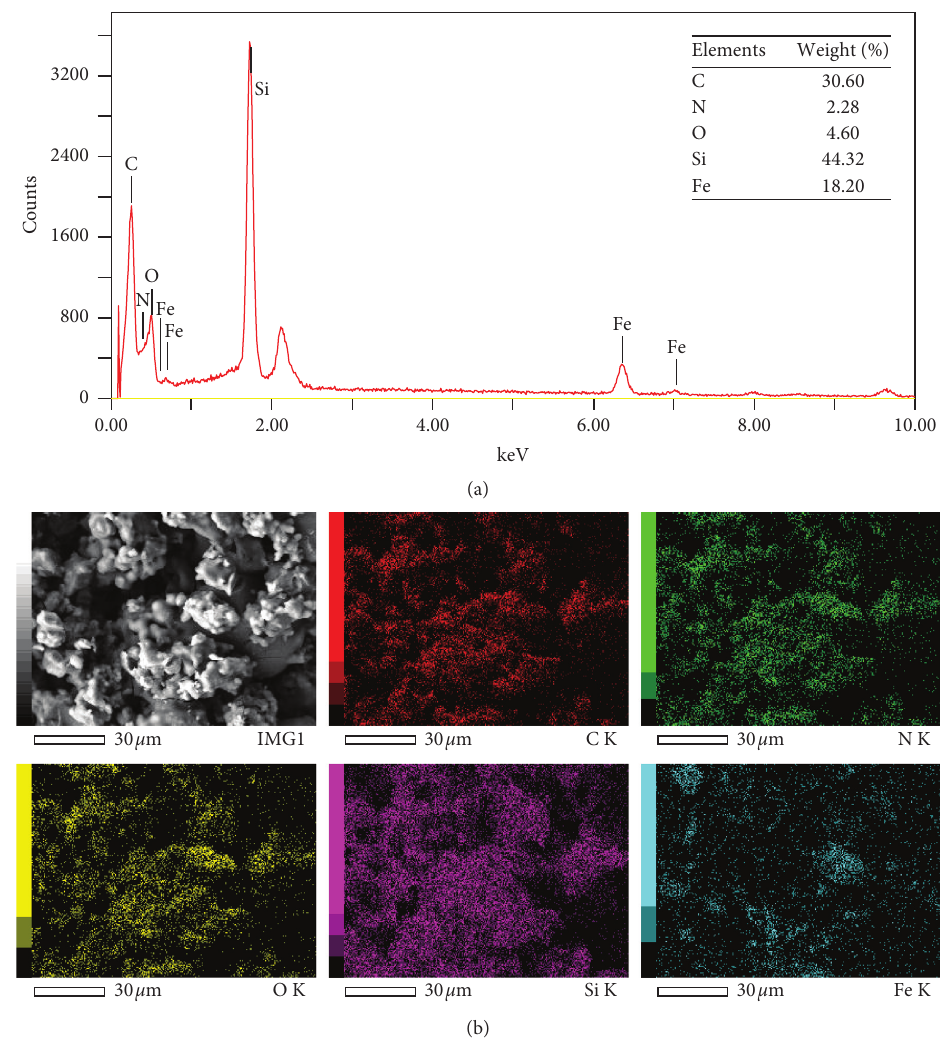
Figure 5: (a) EDX spectrum and (b) SEM image and elemental mapping of ferric oxide-amine.